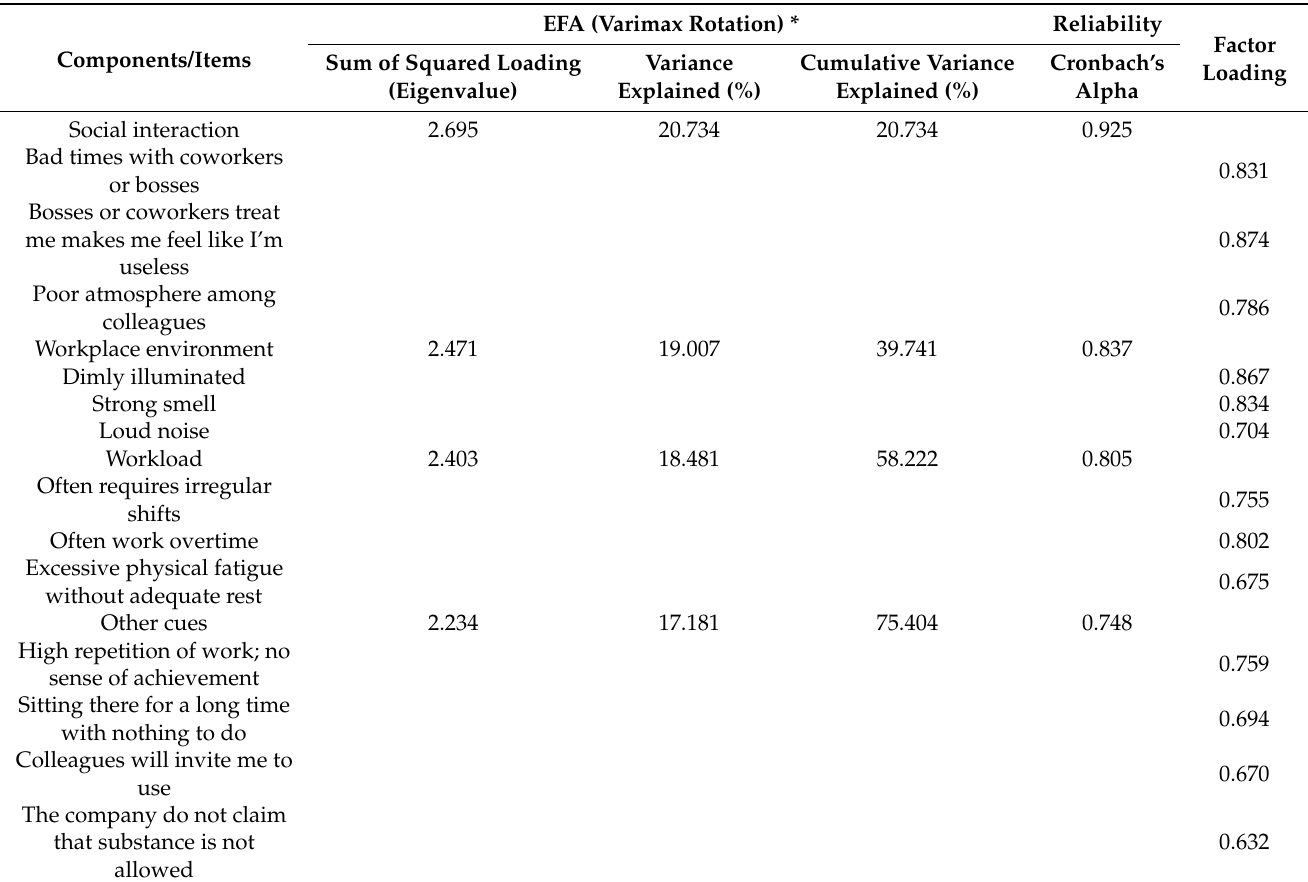
Table 3. Exploratory factor analysis for Workplace Substance Reuse Questionnaire (Illegal